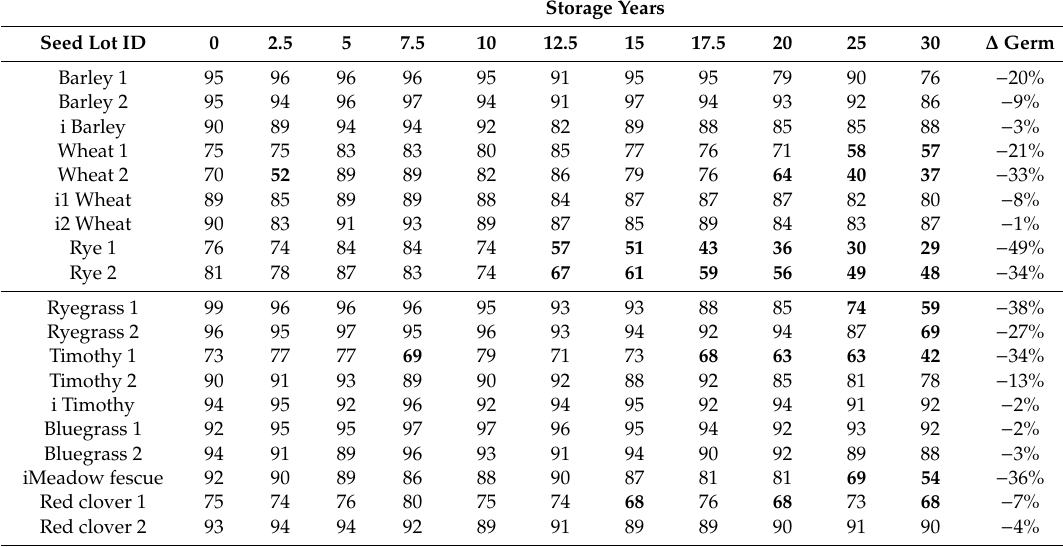
Table 1. Germination percentages for all the seed lots (values below 70% in bold), and loss in germination ( ∆ germ) over the first 30 years, calculated by averaging the germination percentage of the three